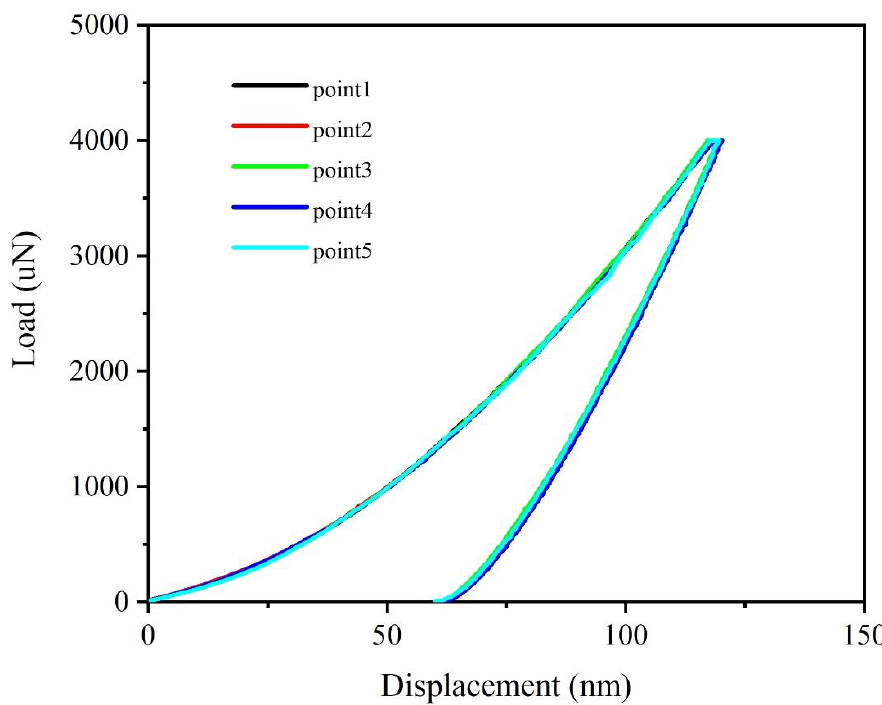
Figure 5. Load-displacement curves of nanoindentation experiment for Ta-rich film. Five points in sample were detected and the elastic modulus and hardness were obtained from these curves.